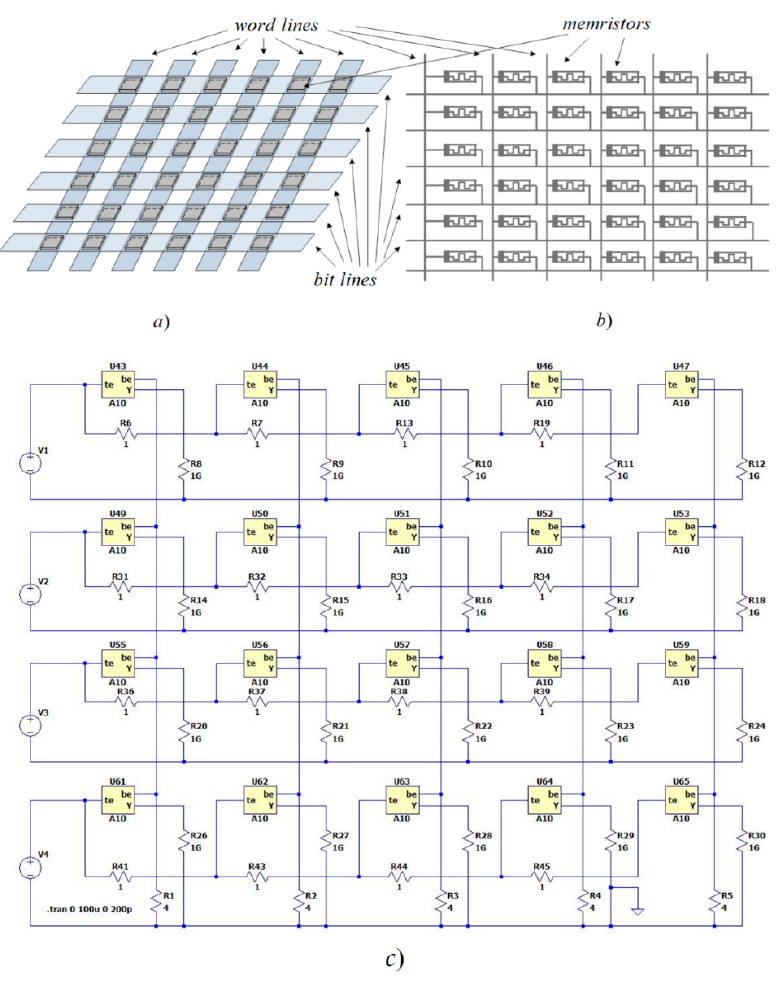
Figure 8. ( a ) Structure of a passive memristor crossbar; ( b ) A substituting equivalent electric circuit; ( c ) A schematic of the analyzed memory crossbar in